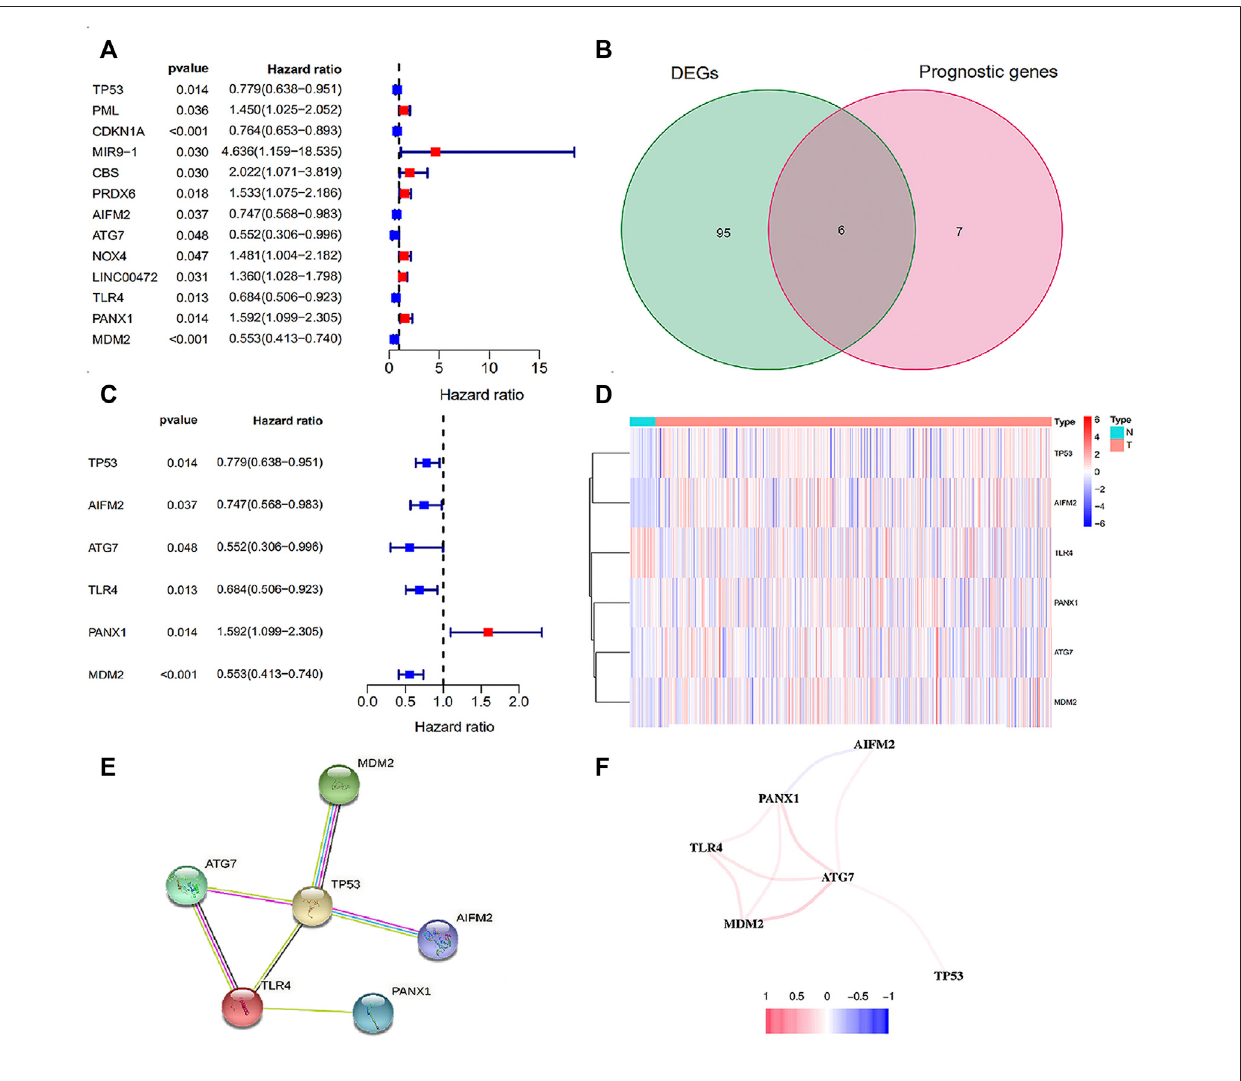
FIGURE 1 | The screening of FRGs related to prognosis. (A) The forest plot of 13 prognosis-related FRGs; (B) The Venn plot of intersection FRGs. (C) The forest plot of intersection FRGs; (D) The heatmap of intersection FRGs; (E) The PPI network of the 6 FRGs; (F) The correlation network of the 6 FRGs. Red line: the positive correlation; blue line: the negative